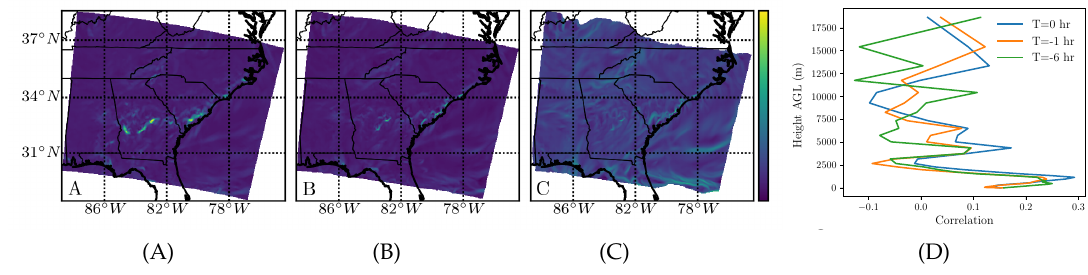
Figure 5. The same as in Figure 4, but for sulfur dioxide (SO 2